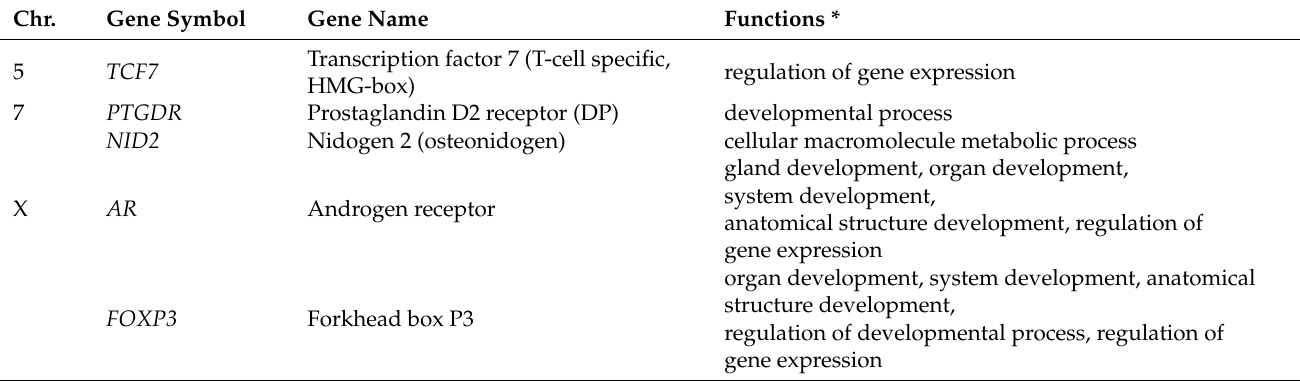
Table 5. Developmental process or gene expression related genes, located within the candidate regions in O. aries